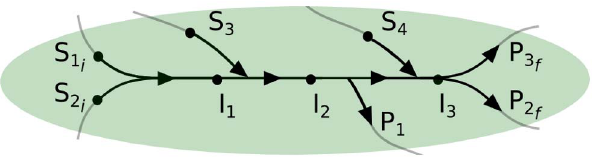
Figure 2. Representation of a metabolic function and its metabolites. Shown is a metabolic pathway with four reactions, represented by the arrows. The dots represent the metabolites, which are categorized as substrates S , intermediates I and products P with the subgroup of initial substrates S i and final products P f